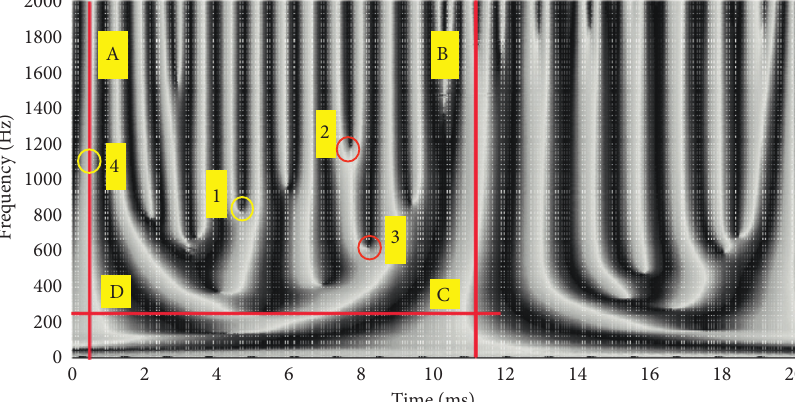
Figure 6: Grayscale images of phase angles.